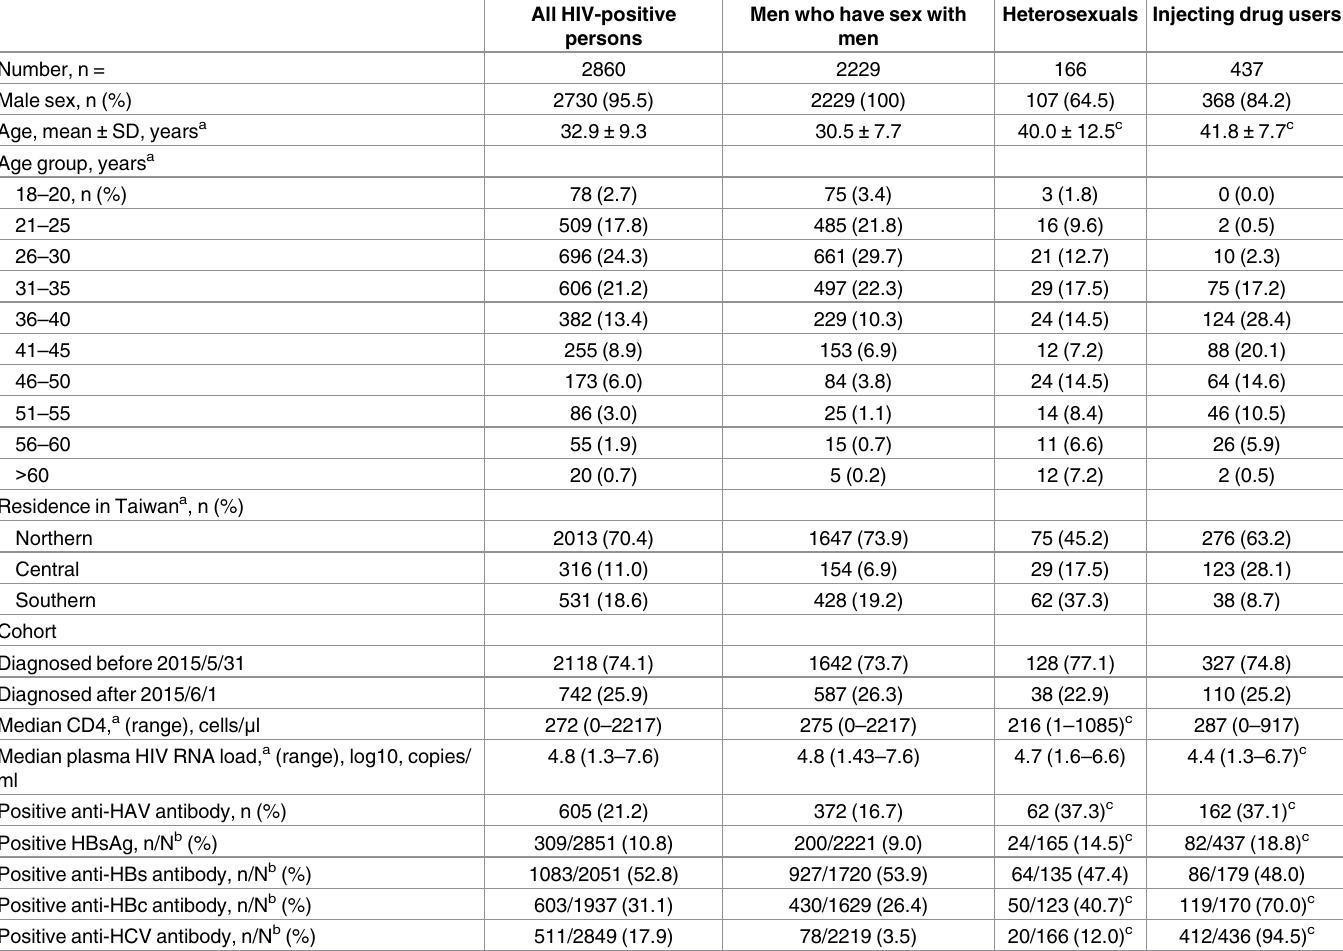
Table 1. Demographic and clinical characteristics of HIV-positive patients with different routes of HIV transmission,